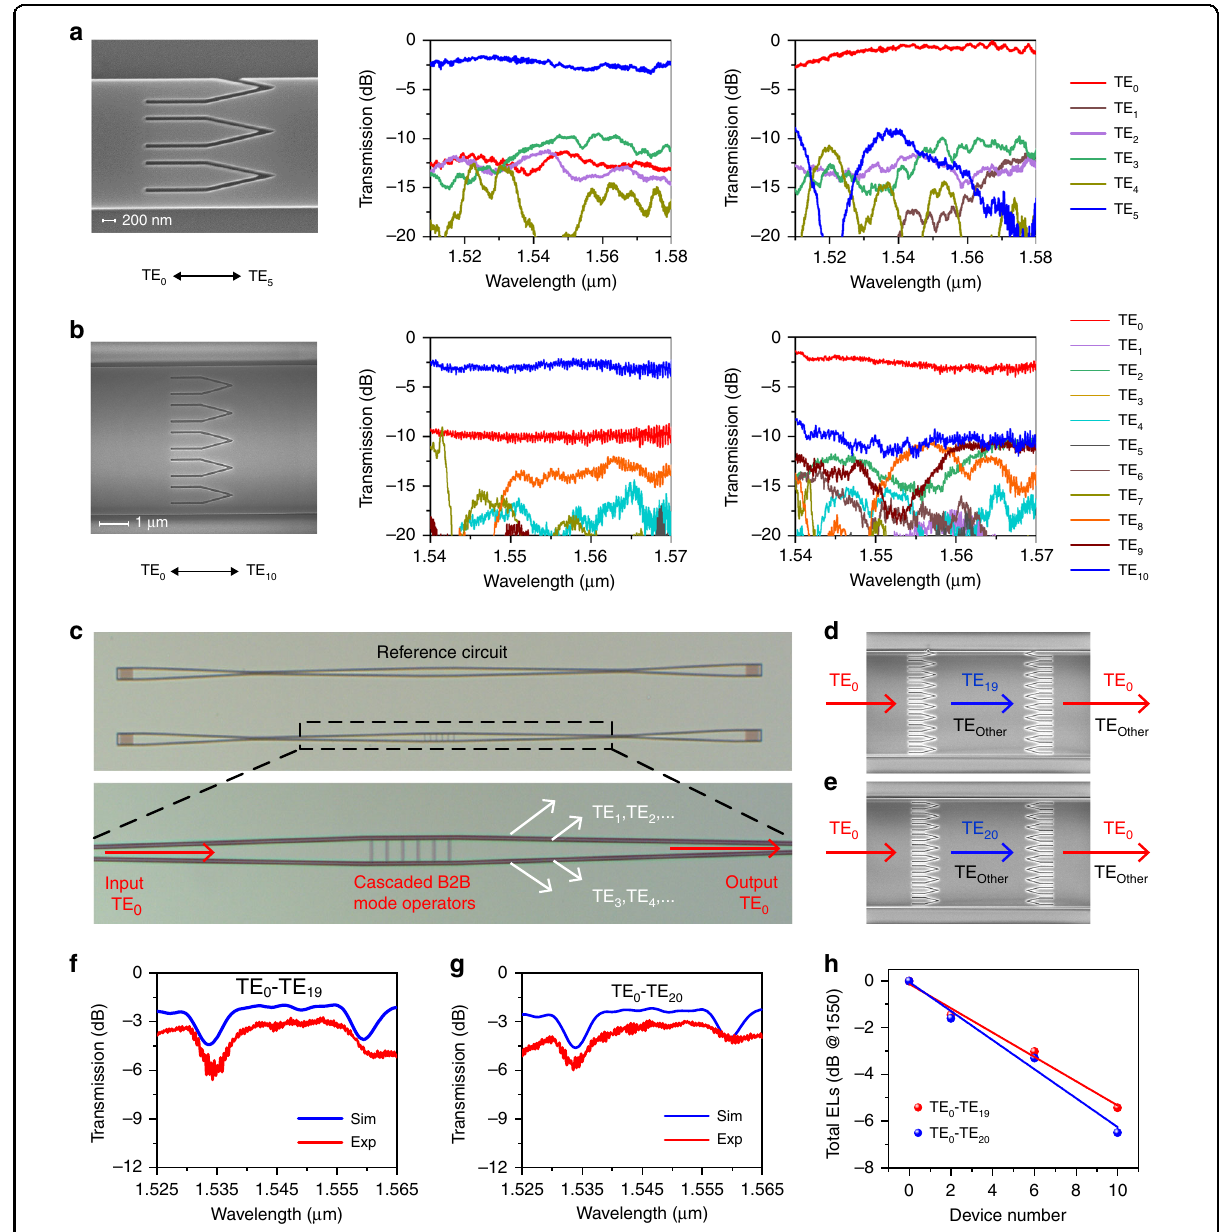
Fig. 4 Experimental results of high-order mode operators. a Displayed from left to right are the SEM image of a fabricated TE 0 -TE 5 mode operator (left), the measured mode conversion ef fi ciency when the input is the TE 0 mode (middle), and the TE 5 mode (right). b Similar results corresponding to the TE 0 -TE 10 mode operator. c Microscope pictures of the fabricated PIC consisting of a mode spot size converter, multiple cascaded B2B mode operators, and a high-order mode fi lter. d , e SEM images for the zoom-in view of two B2B high-order mode operators. f , g Measured transmission spectra for six cascaded B2B TE 0 -TE 19 and TE 0 -TE 20 mode operators, respectively. h The total ELs are linearly dependent on the device